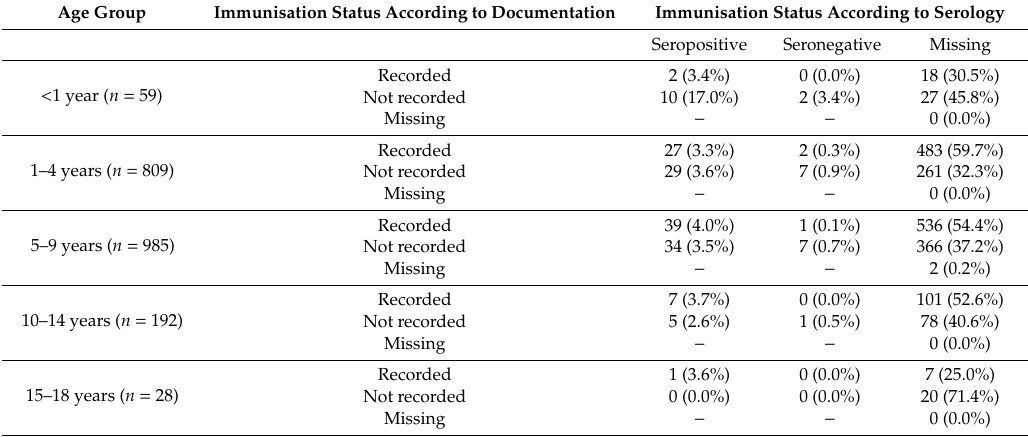
Table A5. Comparison between immunisation status of IAC reported in the documentation and serology for diphtheria, by age group.